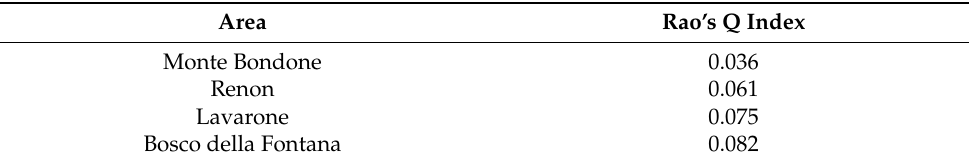
Table 1. Rao’s Q value over the four ECI pixels of each study